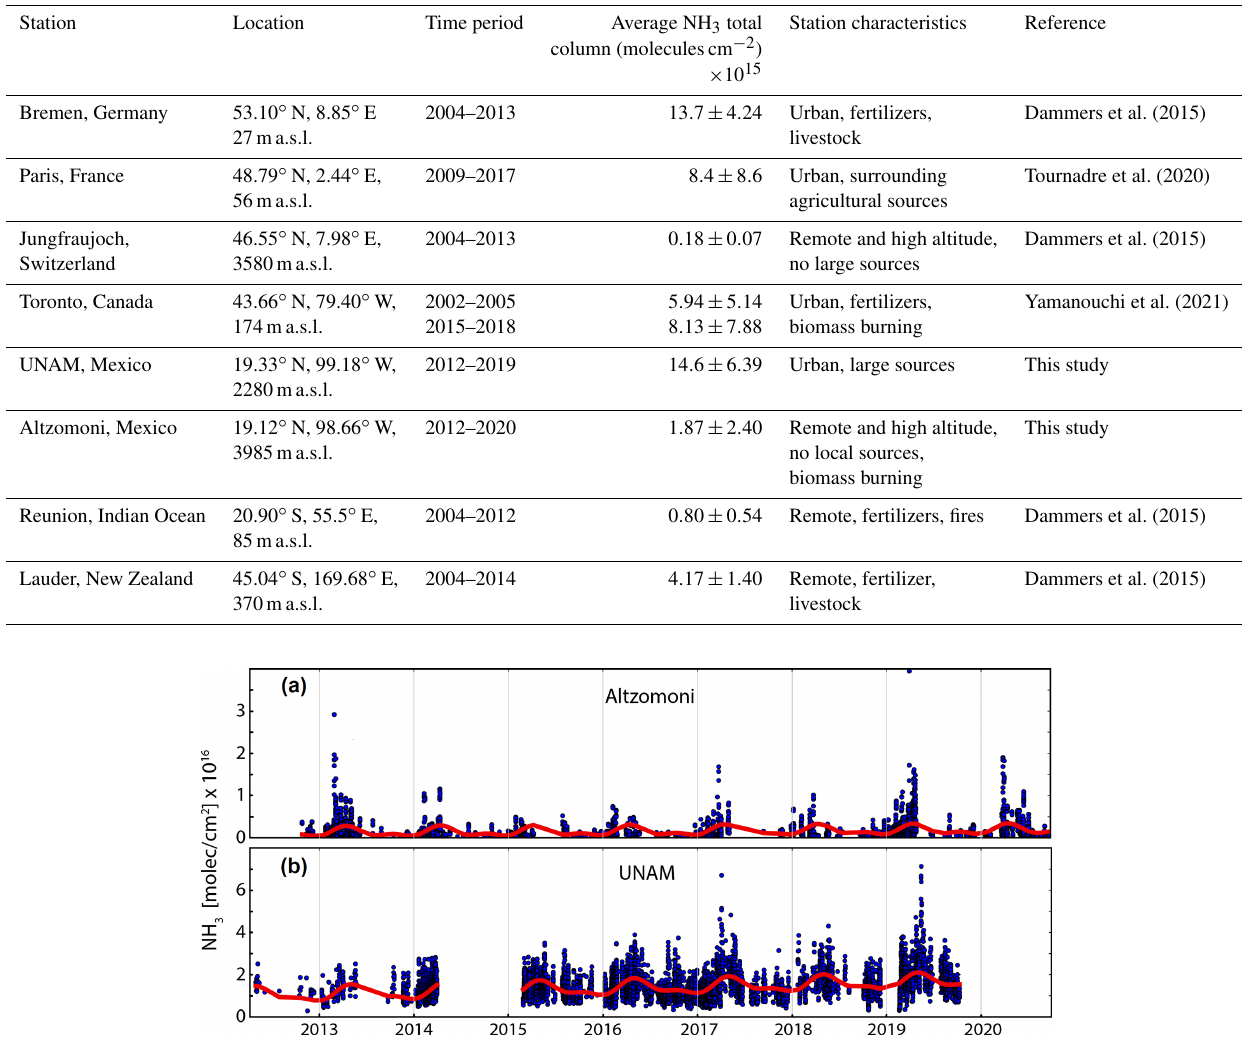
Figure 2. Time series of retrieved FTIR-NH 3 data over (a) Altzomoni and (b) UNAM, with a fitted Fourier series (red) to reproduce seasonality. Note the differences in